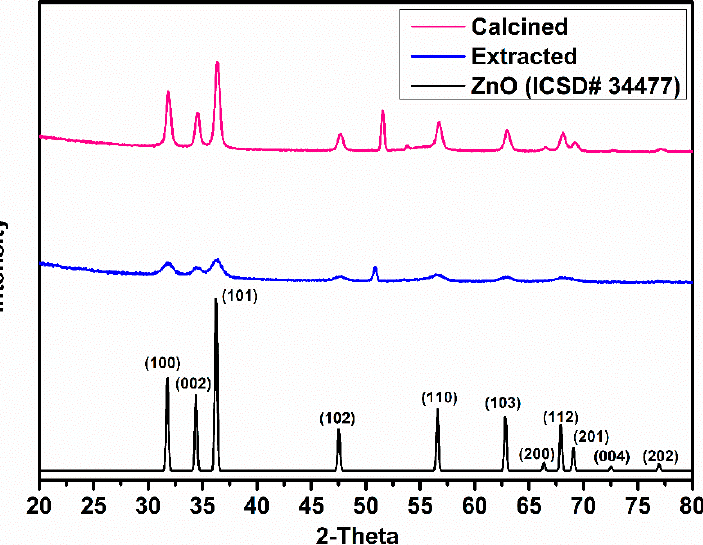
Figure 5. XRD diffractograms of ZnO IOs obtained from PS175-T template after five mineralization cycles. The technique used for template removal is indicated in the legend.